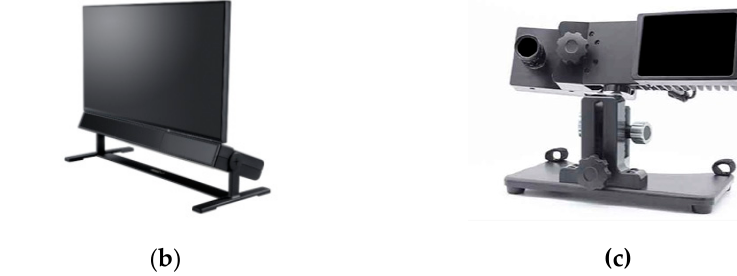
Figure 3. Commercial tabletop eye-trackers: ( a ) Gazepoint GP3 [129]; ( b ) Tobii Pro Spectrum 150 [130]; ( c ) EyeLink 1000 Plus [131].